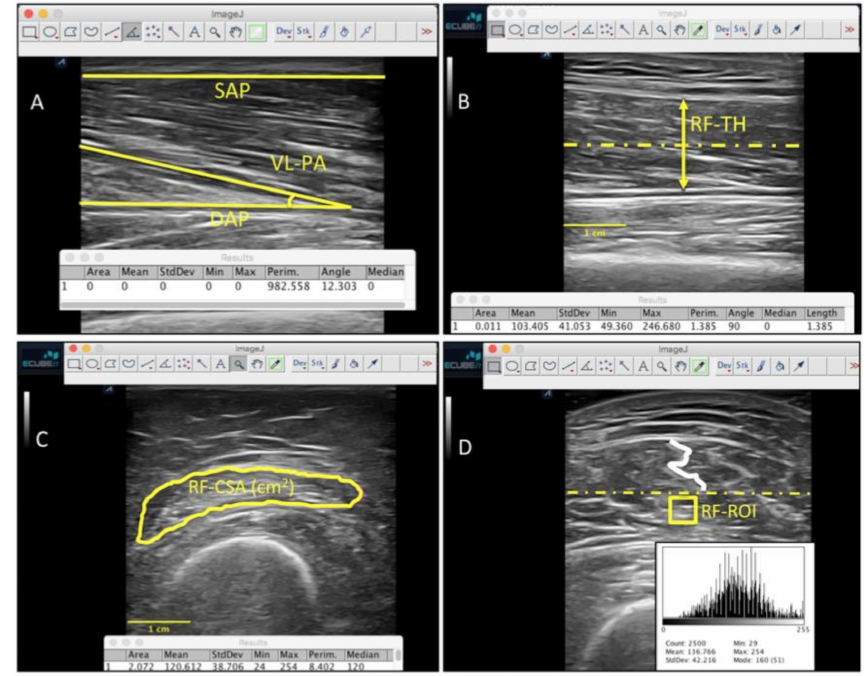
Figure 2. Ultrasound imaging measurements of the morphology and echotexture. ( A ), VL-PA at 65% of the distance between the greater trochanter and the intercondylar notch of the knee; ( B ), RF-TH at 50% of the distance between the anterior superior iliac spine and the superior edge of the patella; ( C ), RF-CSA at 65% of the distance between the anterior superior iliac spine and the superior edge of the patella; ( D ), RF-ROI at 50% of the distance between the anterior superior iliac spine and the superior edge of the patella for the extraction of echotextural variables (echointensity and echovariation). Abbreviations: DAP, deep aponeuroses; SAP, superficial aponeuroses; RF-CSA, cross sectional area of the rectus femoris at 65%; RF-TH, thickness of the rectus femoris at 50%; RF-ROI, range of interest of the rectus femoris;